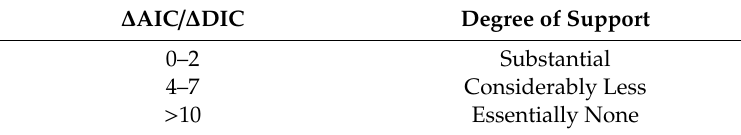
Table 2. Interpretation of the change in Akaike information criterion ( ∆ AIC) and deviance information criterion ( ∆ DIC) for assessing model support. Adapted from Burnham and Anderson [31] and McCarthy [33]